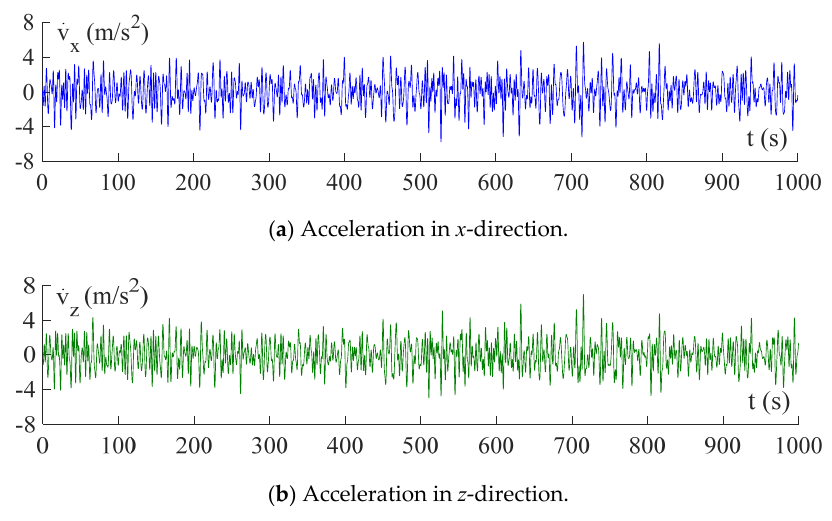
Figure 8. Samples of wave-particle accelerations on the sea surface.